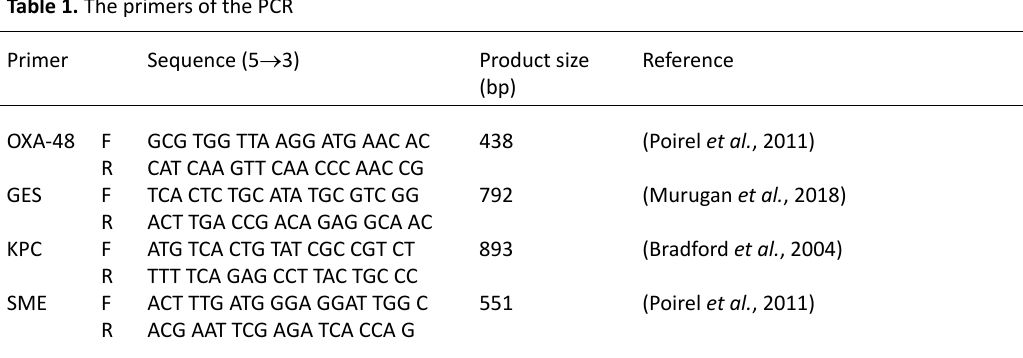
Table 1. The primers of the PCR Primer